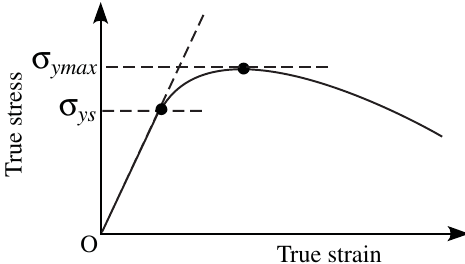
Fig. 5. Definition of stress at plastic deformation onset and maximum stress.